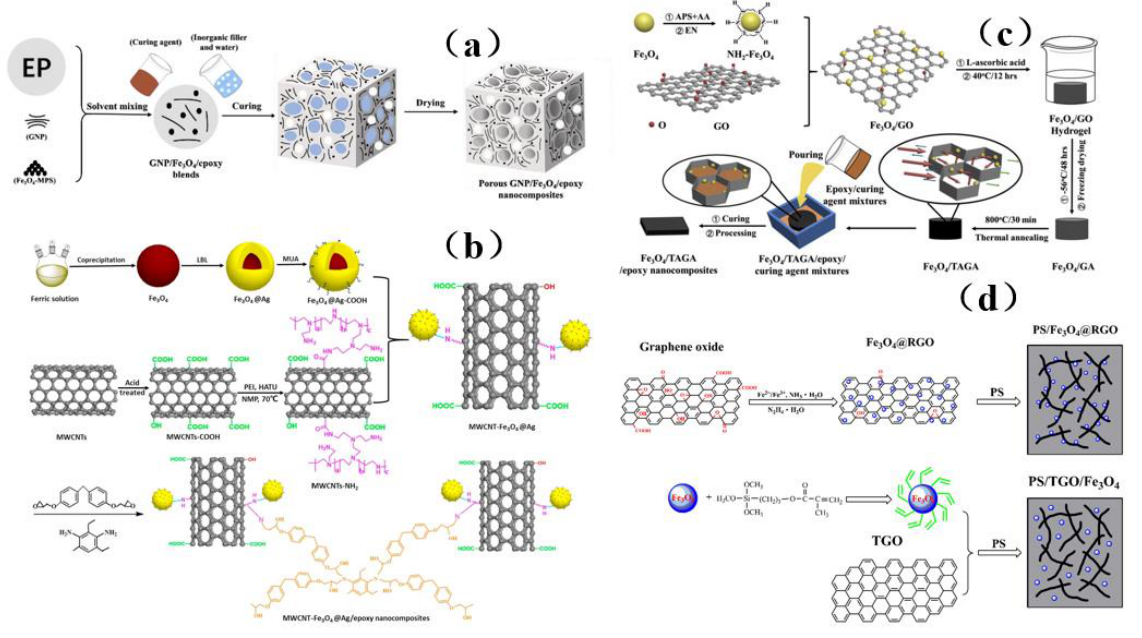
Figure 20. ( a ) Schematic diagram of porous GNP/ Fe 3 O 4 /epoxy nanocomposites prepared by